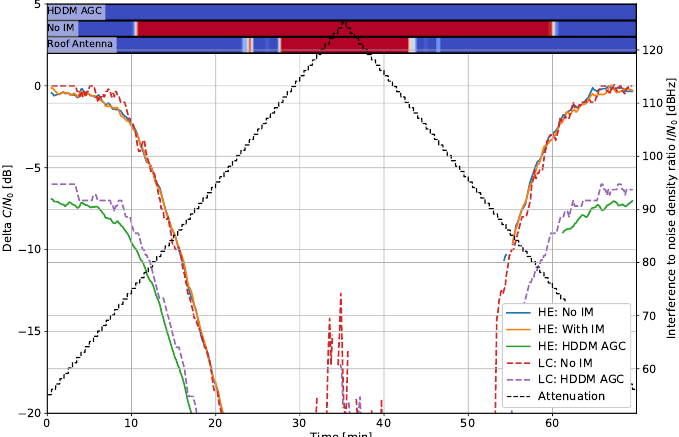
Figure 10. Interference #7: Delta C / N 0 for filtered noise with 35 MHz bandwidth.